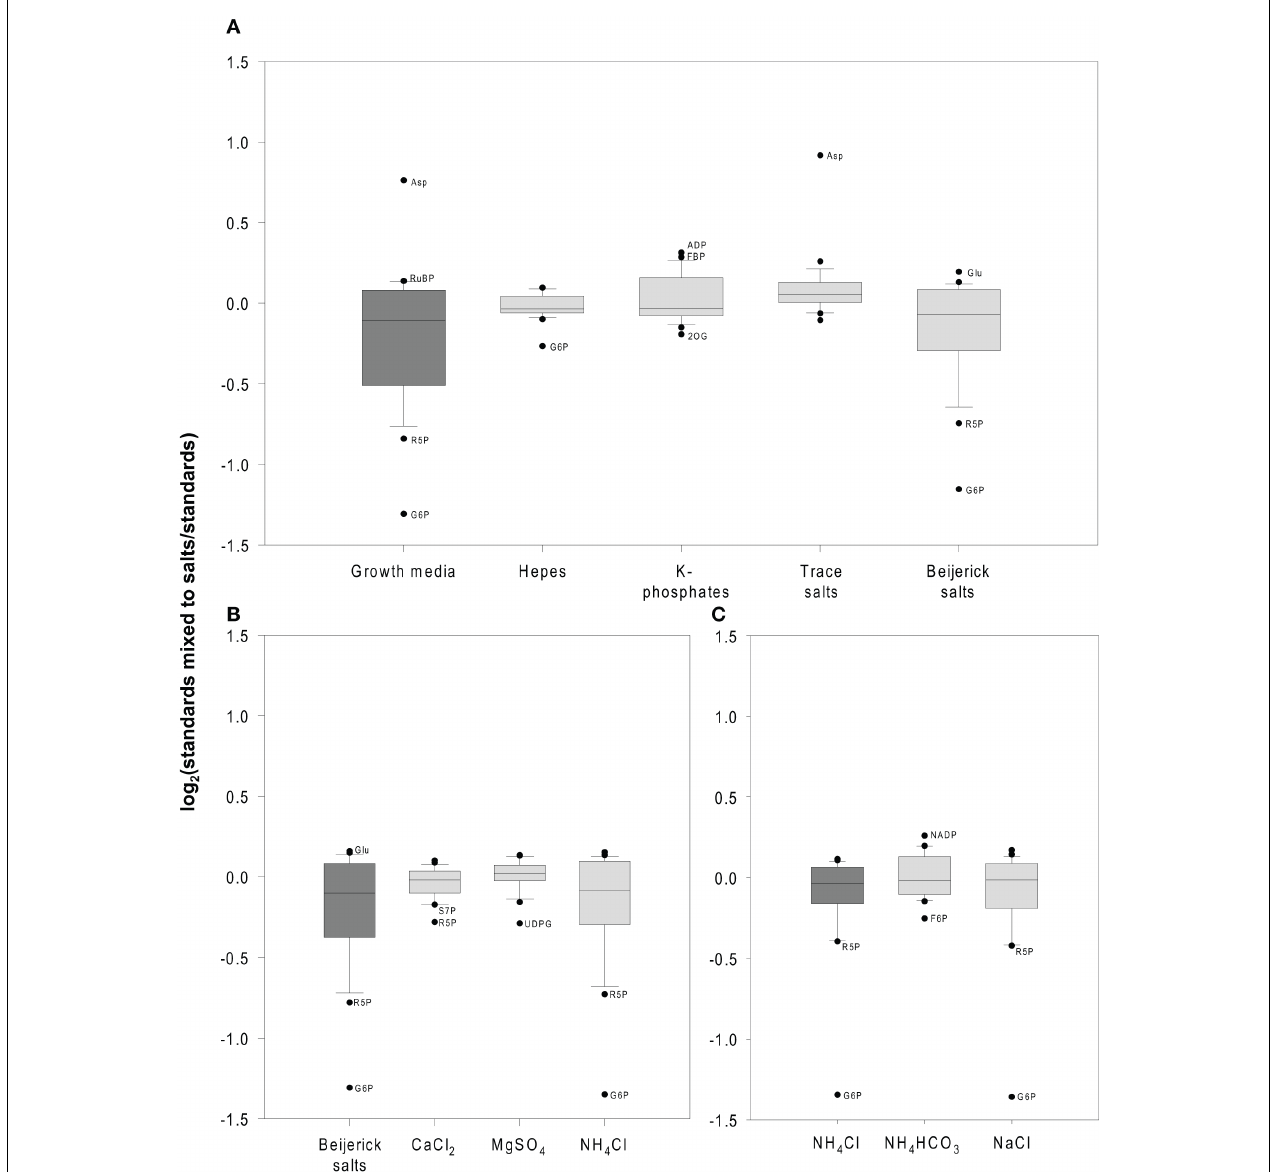
Beijerinck salts (dark gray) and independently to its components CaCl 2 , MgSO 4 , and NH 4 Cl (light gray). (C) A third experiment investigated if the anion or the cation was responsible for ion suppression caused by ammonium chloride. Standards were mixed to NH 4 Cl (dark gray), NH 4 HCO 3 , or NaCl (light gray).The data is shown as box plots of the average values (calculated from three technical replicates) for 24 metabolites. Significant outliers ( p < 0.05) are identified in the figure panels. For a complete list of percentage of ion suppression and enhancement for all metabolites see TableA1 in